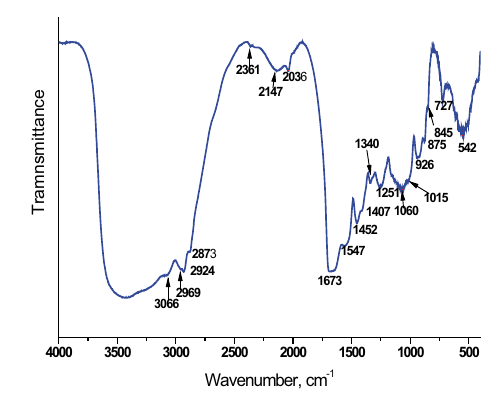
Figure 3. FTIR of pure gelatin